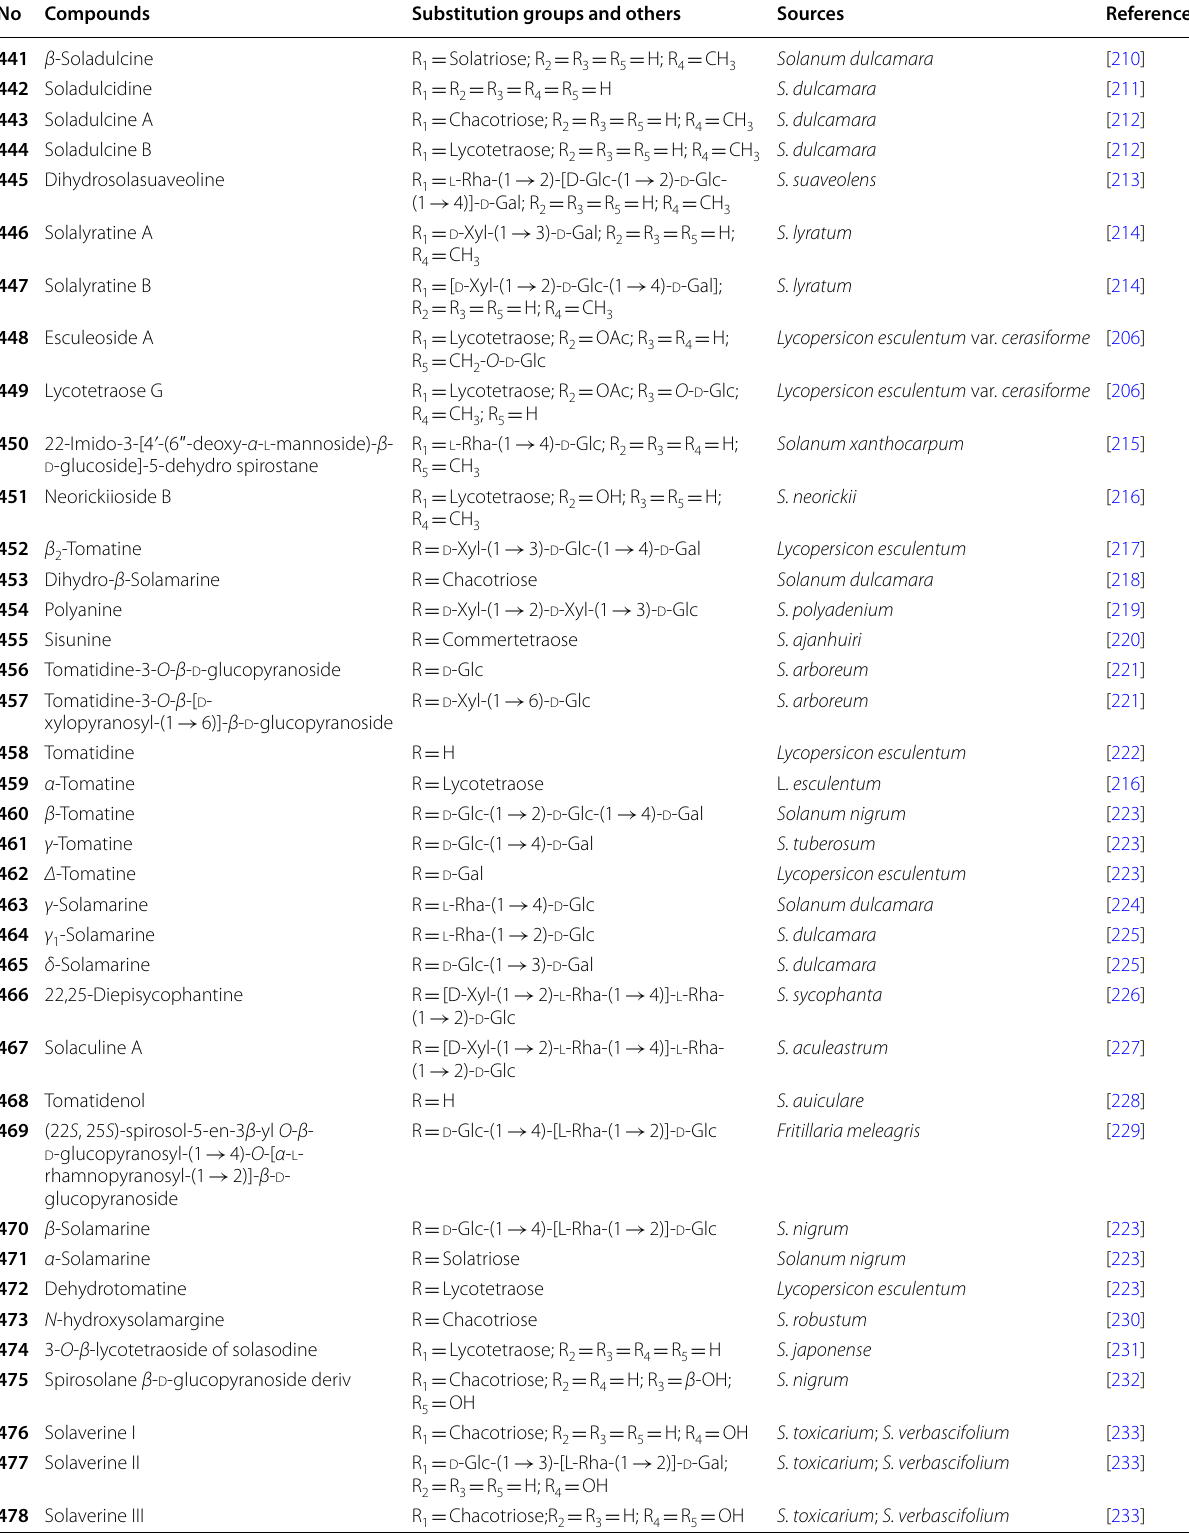
Table 9 Structures and sources of spirosolane type steroidal alkaloids